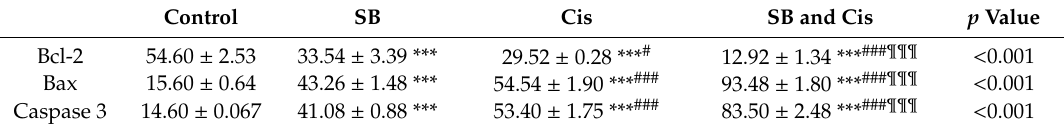
Table 6. Statistical analysis for Bax, Bcl2 and caspase-3 expression in